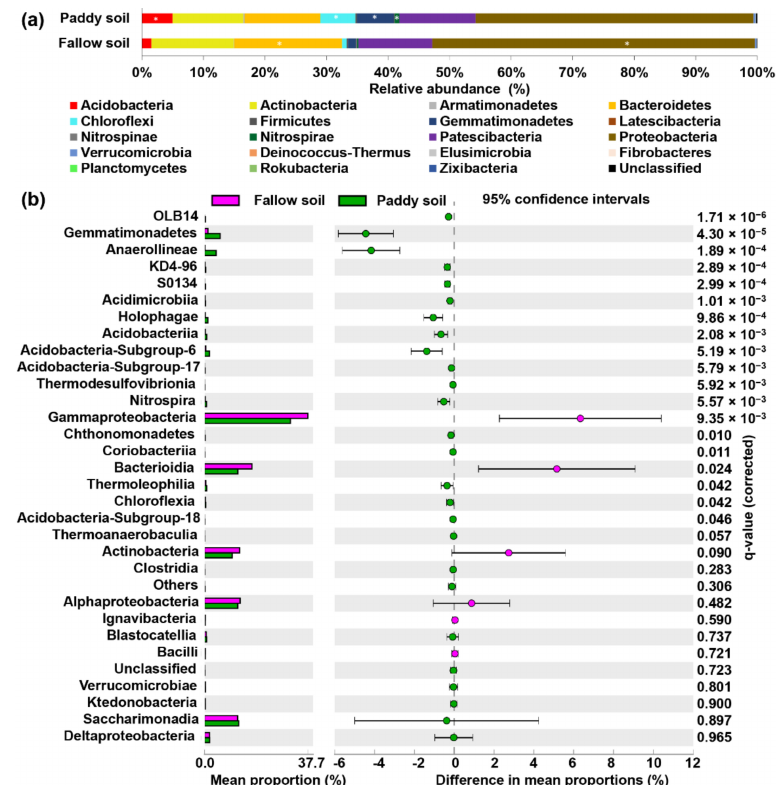
Figure 3. Relative abundance of bacterial phyla and classes detected in the fallow and paddy soil. ( a ) Dominant phyla with the relative abundance in both soil types, asterisk indicate relative abundance of the phyla is significantly higher in that type of soil; ( b ) Relative abundance of bacterial classes in both soil types, determined by Welch’s t -test with a Benjamini–Hochberg FDR test correction to calculate q